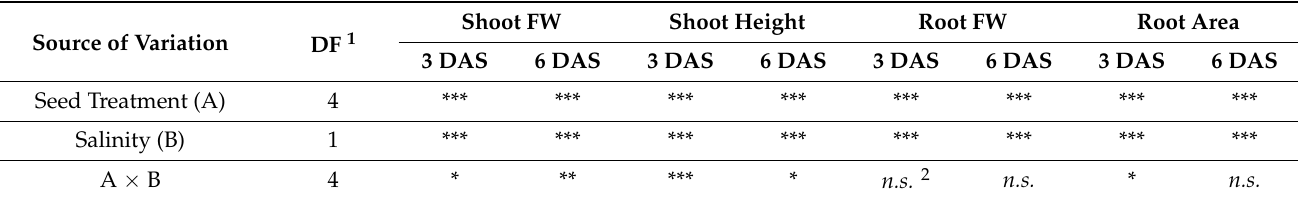
Table 2. Significance of the effects of seed treatments (A), salinity stress (B) and their interactions on reported traits of perlite-grown maize ( Zea mays cv. Caramelo) seedlings (3 or 6 days after sowing (DAS)) according to two-way analysis of variance (ANOVA) ( α = 0.05).